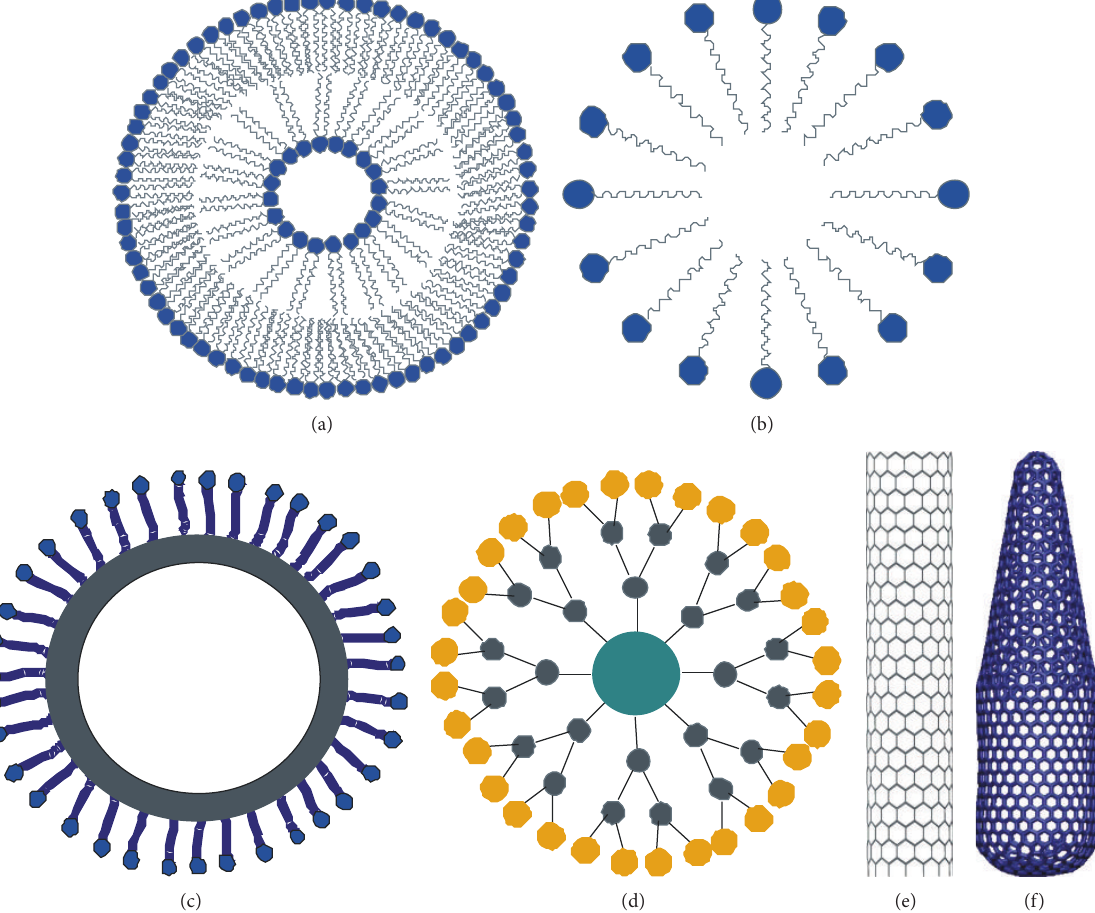
Figure3:Schematicrepresentationofnanocarriers:(a)liposome,(b)micelle,(c)polymericnanoparticle,(d)dendrimer,(e)carbonnanotube, and (f) carbon